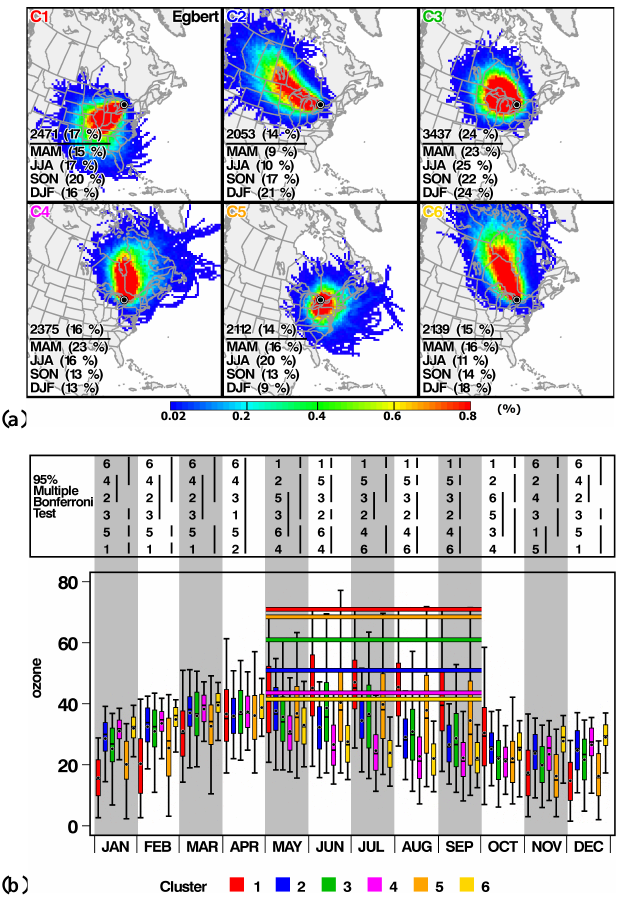
Fig. 3. (a) : Probability density plots of backward trajectories for Egbert (44 ◦ 13 0 57 00 N, 79 ◦ 46 0 53 00 W), located in Ontario, Canada. Trajectory clusters are shown as probability density plots whereby the blue-to-red colors in the grid squares represent the relative fre- quency with which trajectories passed over the grid squares (calcu- lated as the number of trajectories in the cluster passing over a grid square divided by the total number of trajectories passing over all grid squares in all clusters). Shown only are the grid cells with prob- ability greater than 0.02. Those grid cells with probability greater than or equal to 0.8 are shown with the same color. (b) : Monthly box-and-whisker plot of the six-hour-average ozone mixing ratios (ppb) associated with the trajectory clusters in Fig. 3a. The endpoint of the upper whisker, upper edge, dot inside, line inside, lower edge of the box and endpoint of the lower whisker show the 95th, 75th, mean, median, 25th and 5th percentiles,